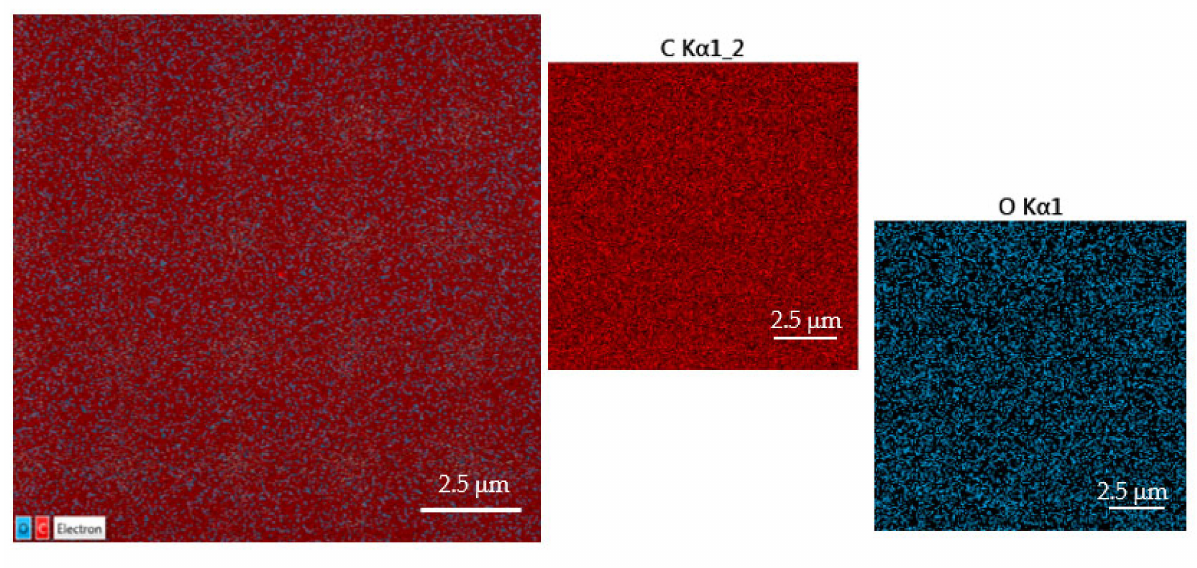
Figure 6. SEM-EDX images and spectrum of pristine COC.